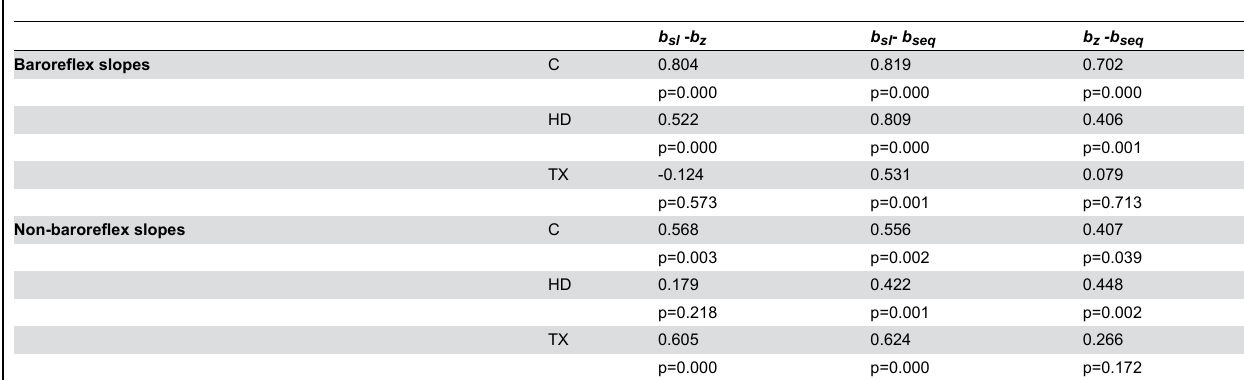
Table 2. Correlation coefficients of baroreflex and nonbaroreflex slopes determined by 1 min sliding windows method ( b with those obtained by the sequence technique ( b and in transplanted (TX)